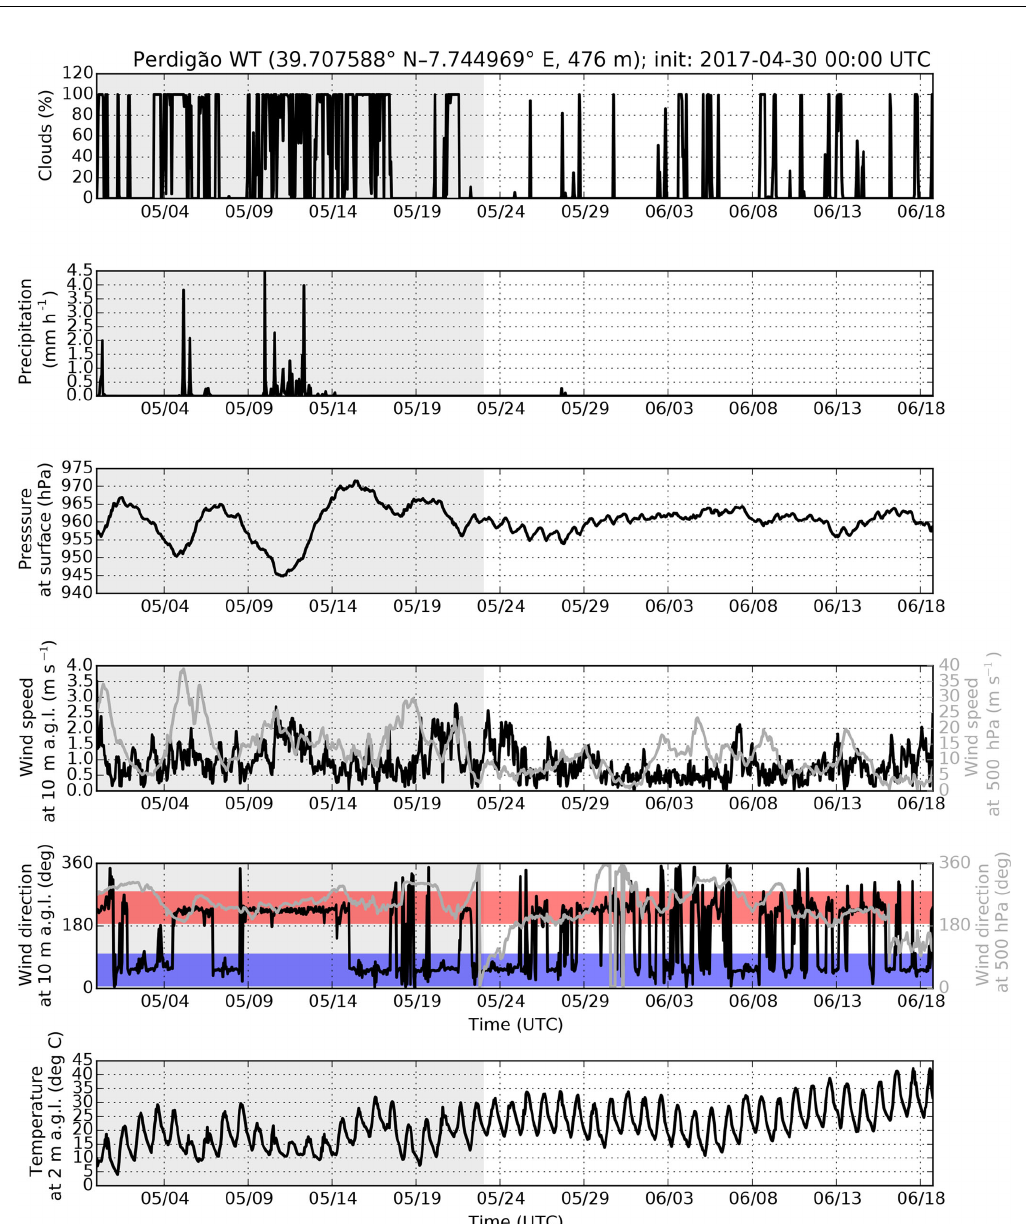
Figure 3. WRF D3 meteogram for 30 April to 18 June 2017 at the location of the WT on the SW ridge. The red and blue shaded areas in the wind direction plot mark cross-valley surface winds from the SW and NE directions, respectively. The grey shading separates the campaign synoptically into phase I and phase II. Dates are in mm/dd